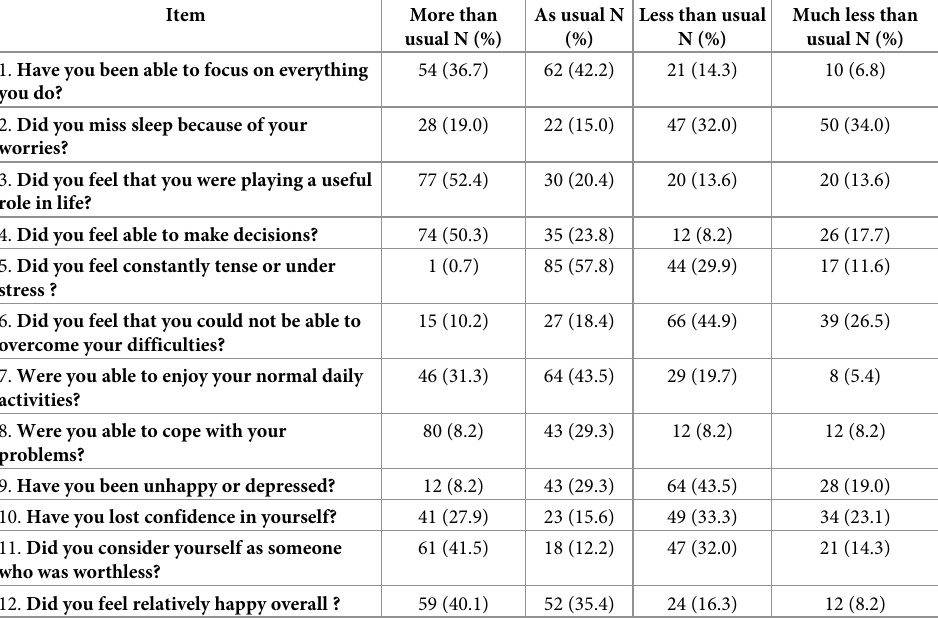
Table 2. Distribution by GHQ-12 items of medical students, Sousse, Tunisia, 2021. Item More than